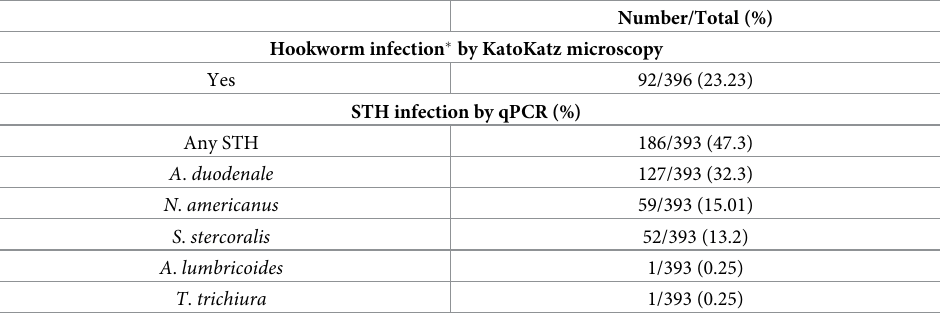
Table 2. STH prevalence by microscopy and